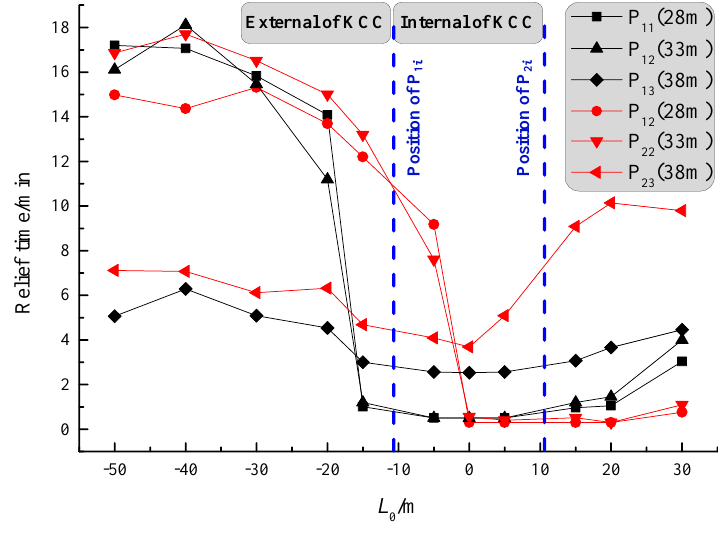
Figure 5. The results of water pressure monitoring test in different vertical depth.